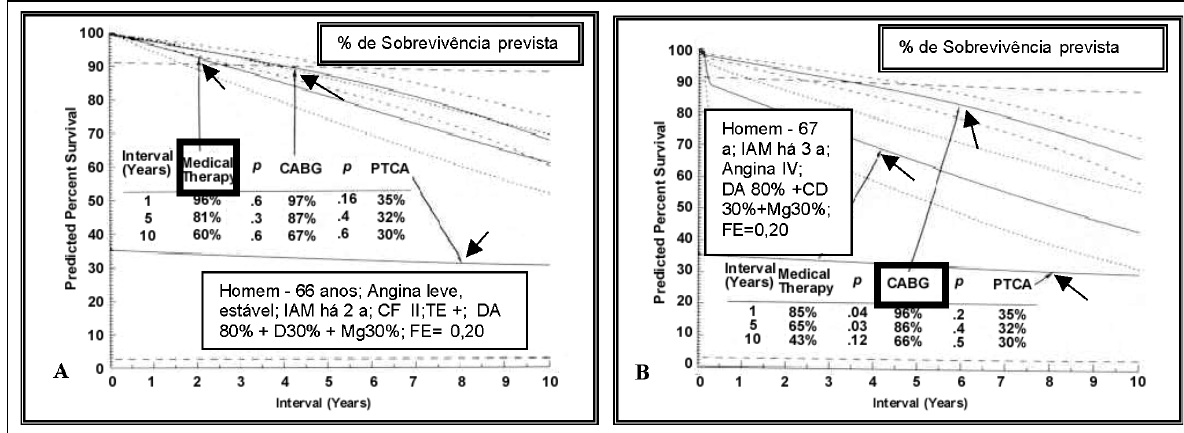
Fig. 6 - Curvas relacionadas ao caso 3. (Fonte: Kirklin J W & Barrat-Boyes B G. Cardiac surgery. 2.ed. New York: Churchill Livingstone, 1993. v.1).